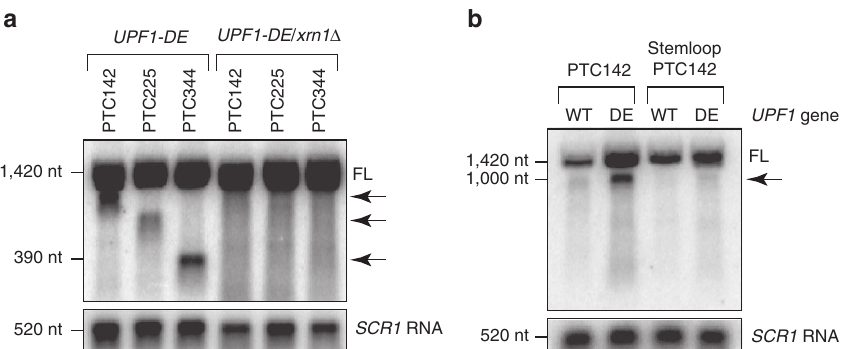
Figure 2 | 3 0 RNA fragments are decay intermediates dependent on XRN1 activity and translation. ( a , b ) Northern blot analysis of PTC-containing PGK1 reporter mRNA in upf1 D cells expressing ATPase-deficient UPF1 in the presence ( UPF1-DE ) or absence of XRN1 ( UPF1-DE/xrn1 D ). ( b ) Reporter mRNA inhibited for translation by a 5 0 stemloop in upf1 D cells expressing either wild-type (WT) or ATPase-deficient (DE) UPF1. Full-length reporter mRNA (FL) and 3 0 RNA fragments (arrow) indicated. RNA levels were normalized to NMD-insensitive SCR1 RNA. Results are representative of three independent experiments. Nt,